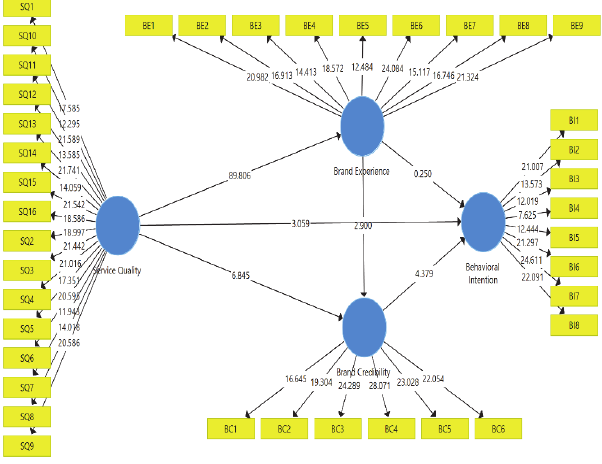
Fig. 2. Outer Model Source: data processed by researchers